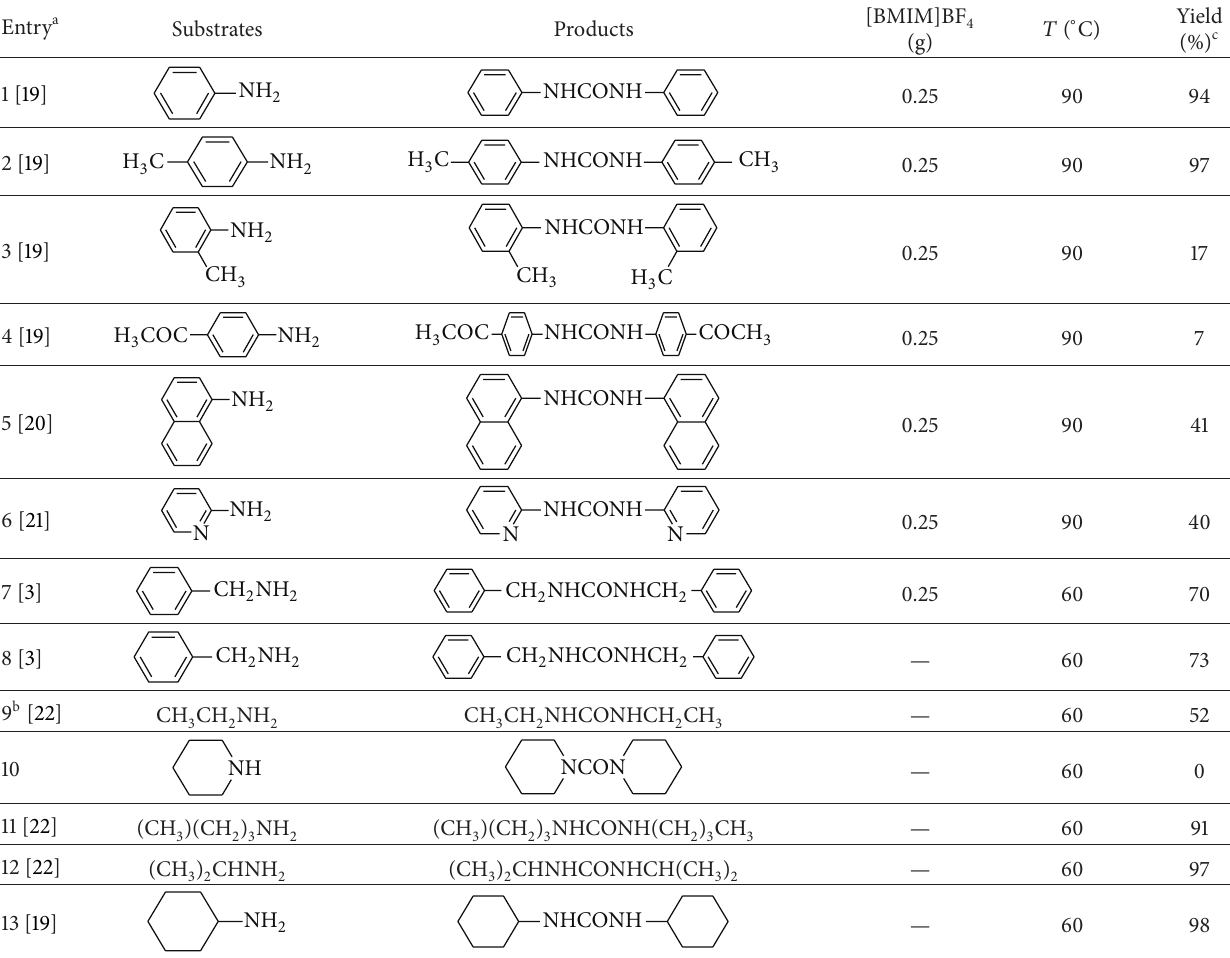
Table 3: The synthesis of symmetrical ureas from organic